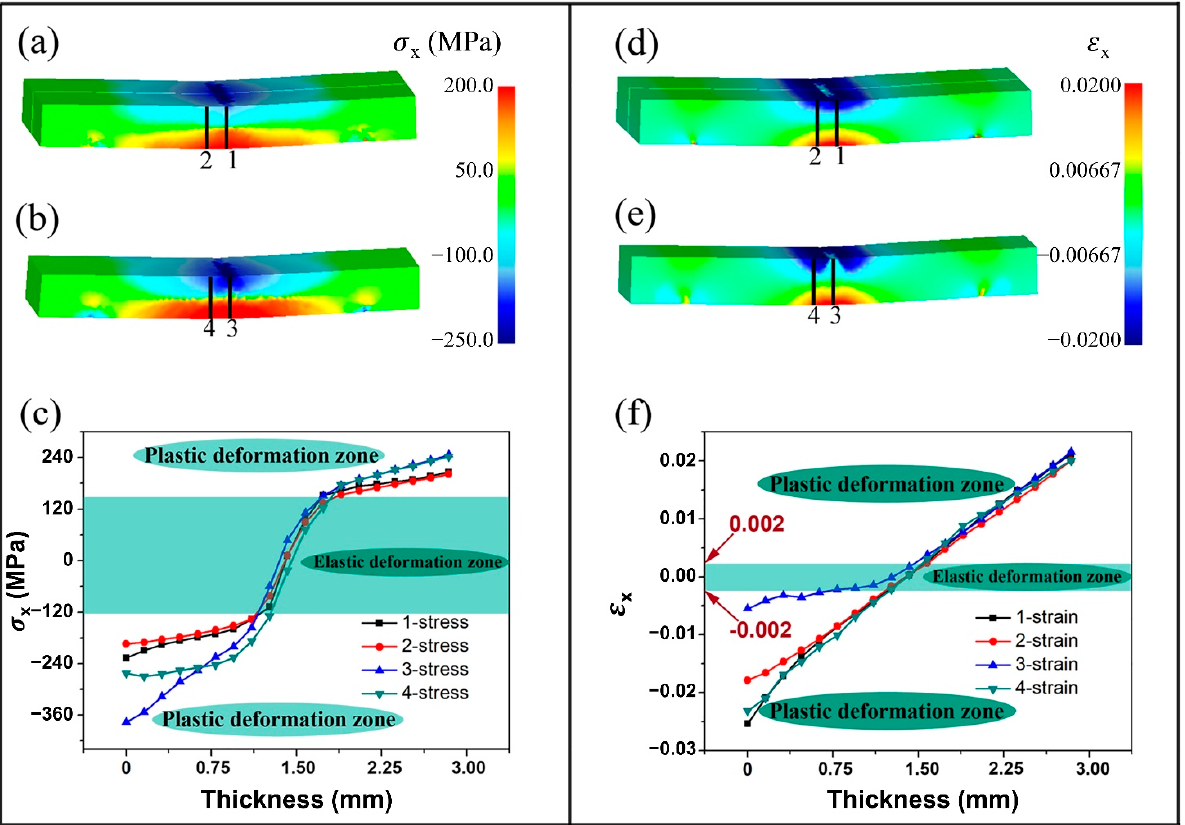
Figure 5. Simulated stress component 𝜎 x ( a , b ) and strain component 𝜀 x ( d , e ) in the side position ( a , d ) and middle position ( b , e ); distributions of stress ( c ) and strain ( f ) along the paths 1, 2, 3 and 4.